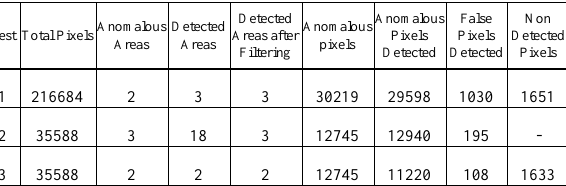
Table 1. Results of the performed